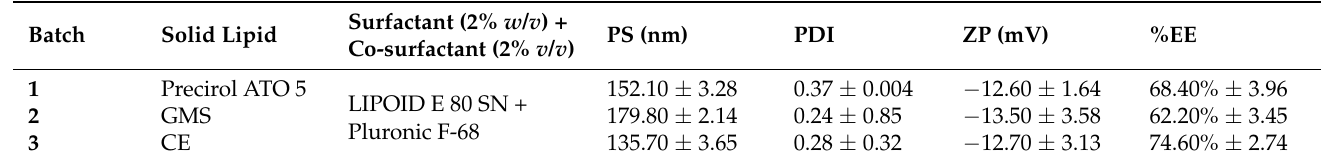
Table 3. Preliminary screening of solid lipid, surfactant and co-surfactant.